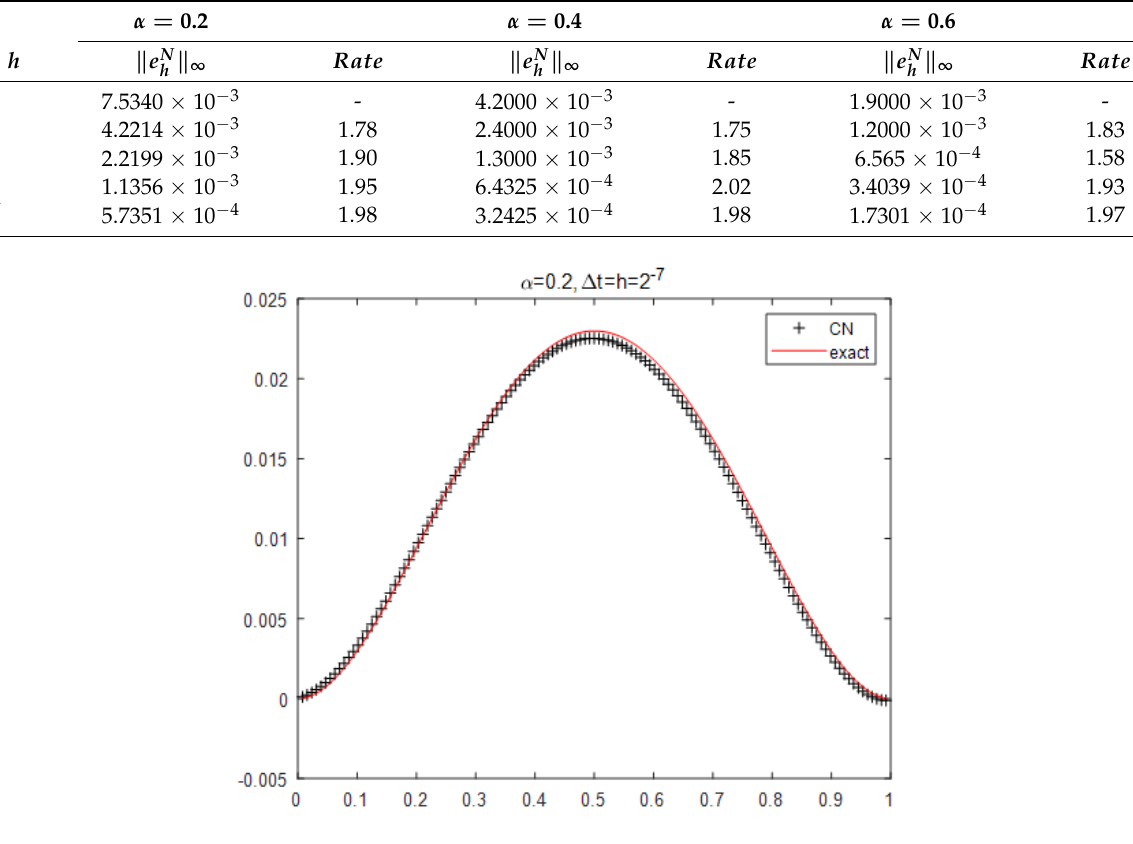
Figure 1. The numerical solution for the Crank-Nicolson scheme and exact solution for Example 1 with α = 0.2, ∆ t = h = 2 − 7 at time T = 1.